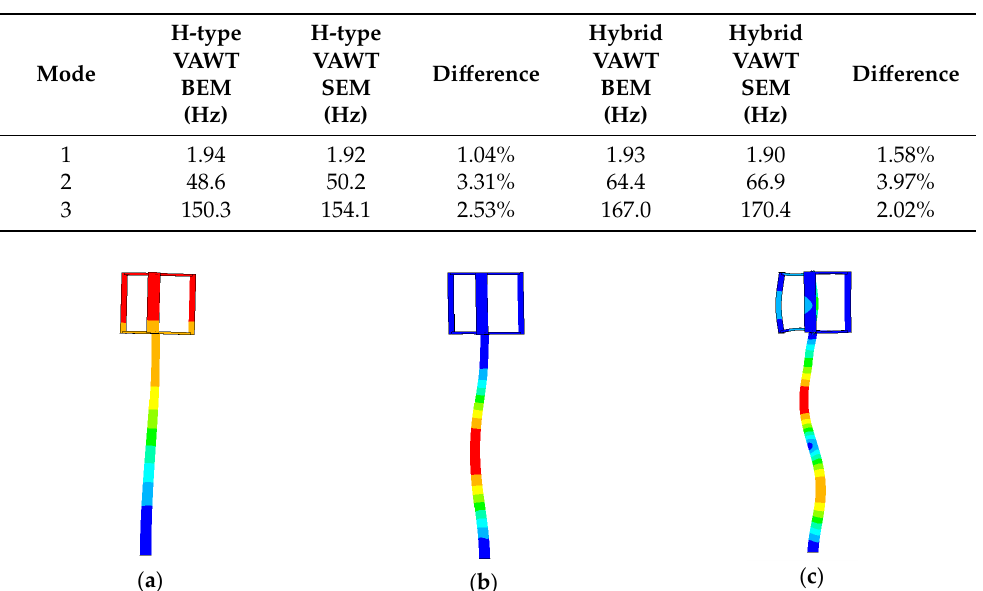
Table 13. Comparison of the first three natural frequencies of the 4 m-mast H-type and hybrid VAWTs from their SEMs that correspond to their X-Y planar motions and the first natural frequencies of the two VAWTs from their BEM.